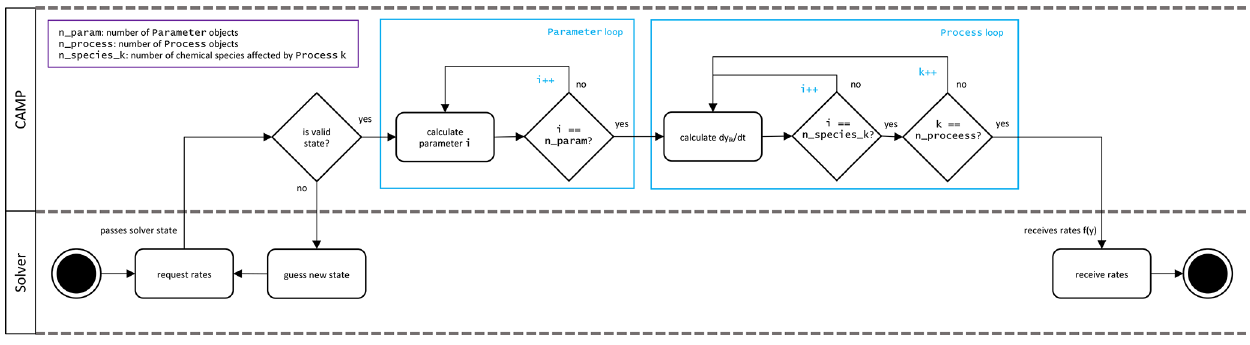
In a similar way, parameterizations and their partial deriva- tives with respect to state variables are accessed through the Parameter interface as described in Sect.